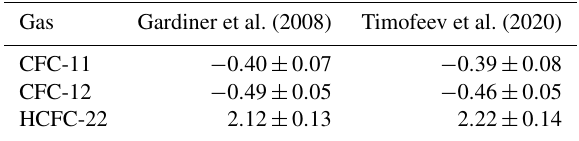
Table 5. Estimated trends of Xgas derived from the FTIR measure- ments at the St. Petersburg site in